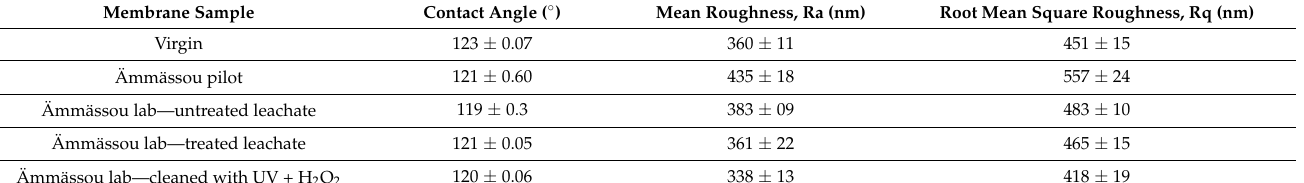
Figure 3. Ammonia flux and acid pH of ( a ) M1, ( b ) M2, ( c ) M3, and ( d ) M4.